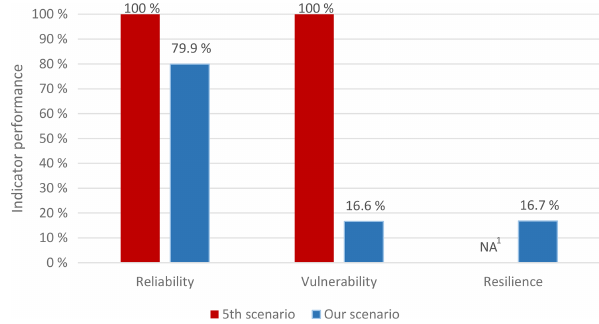
Figure 6. Performance of the indicators for the two scenarios. 1 NA denotes “not applicable”; the resilience indicator only applies when the scenario projects the water storage in the dam to reach the minimum level, impeding water supply to its